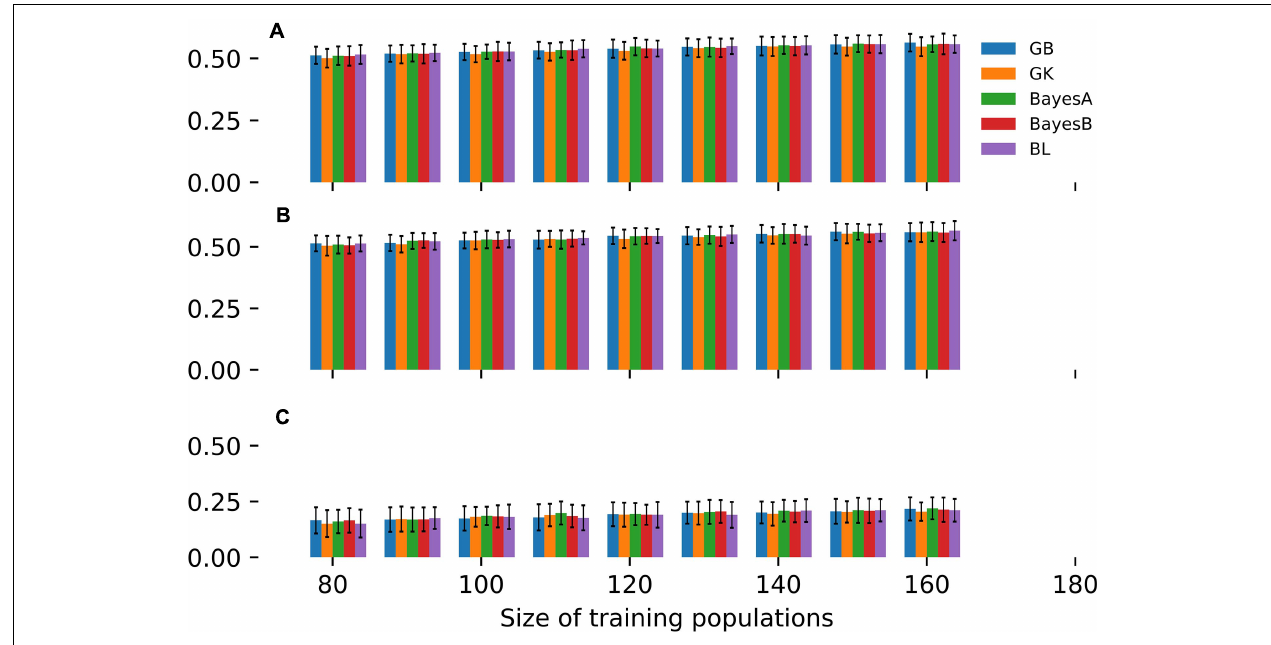
FIGURE 1 | CV of different SE-GP models fitted to GY measured in the MAGIC population. Bars report the values of predictive ability for GY computed in (A) Fio16IN, (B) Fio17IN, and (C) Mar16IN. Bars of different colors point out values of predictive ability computed using GB, GK, BayesA, BayesB and BL models as a function of TP sizes, while the error bars point out the standard deviation of predictive ability values.